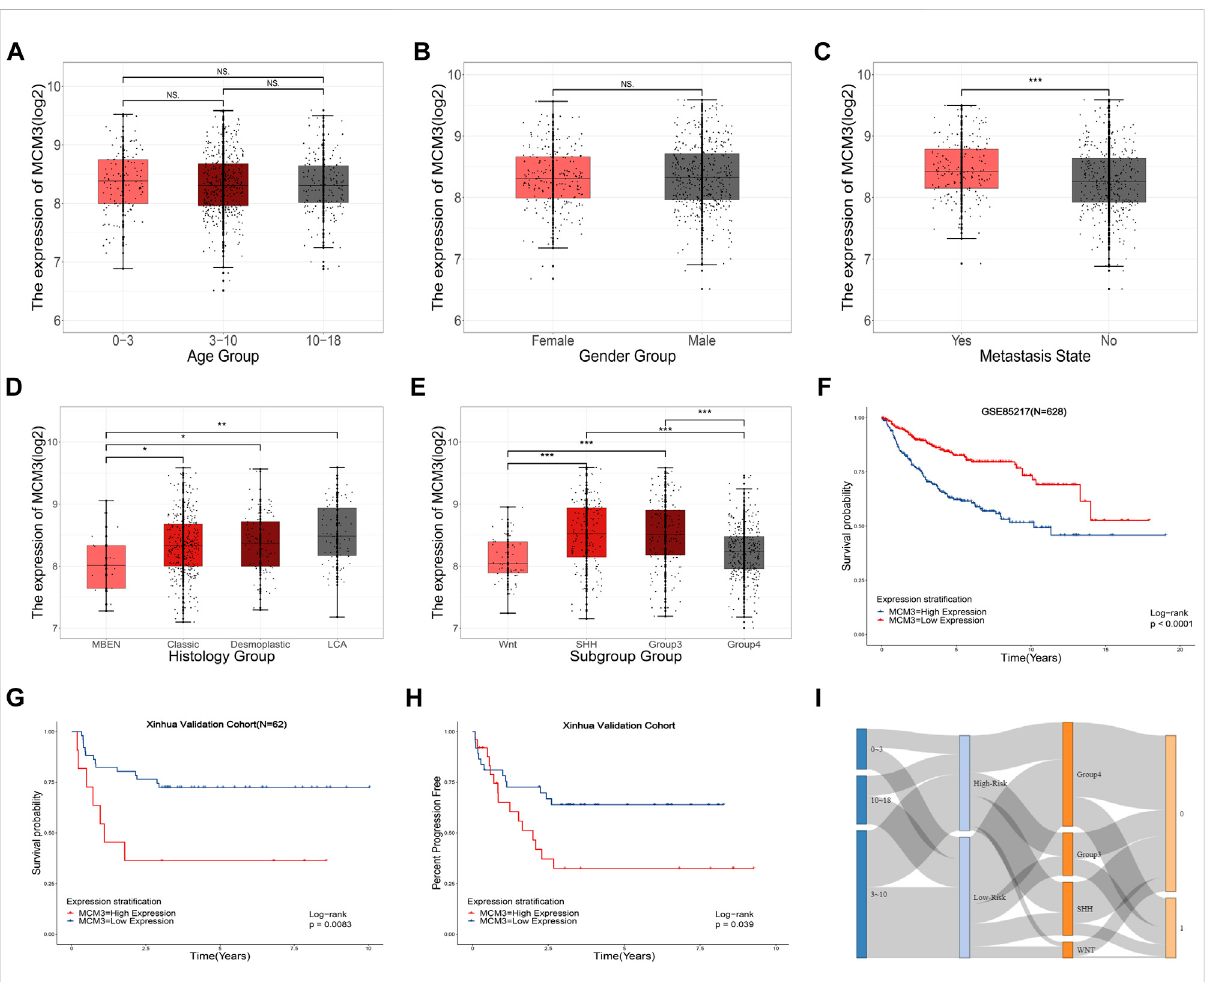
FIGURE 4 Relationships between MCM3 expression and clinicopathologic features. Correlation of MCM3 expression with age (A) , sex (B) , metastasis status (C) , histology (D) and molecular subtypes (E) . MCM3 expression is correlated with OS in samples from children (GSE85217, n = 628) (F) . Validation of the prognostic value of MCM3 in our patient cohort (G) . Correlation of MCM3 expression level with metastasis in our cohort (H) . Relationships among molecular subtype, MCM3 risk classi fi cation, and survival state (I)